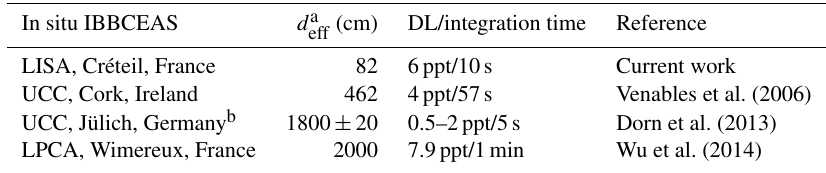
Figure 4. (a) Measured absorption coefficient α(λ) (between 655 and 669nm) with an integration time of 10s (in black); complete fit of NO 2 and NO 3 (in blue) with [NO 3 ] = 6ppt; [NO 2 ] = 630ppb; NO 2 fit only (in green); (b) measured absorption coefficient (in black) without NO 2 contribution and fitted with [NO 3 ] = 6ppt (in red); (c) residue of measured and fitted absorption coefficient. Table 1. Comparison of characteristics and performances of various IBBCEAS devices coupled to simulation chambers for the detection of NO 3 radicals.